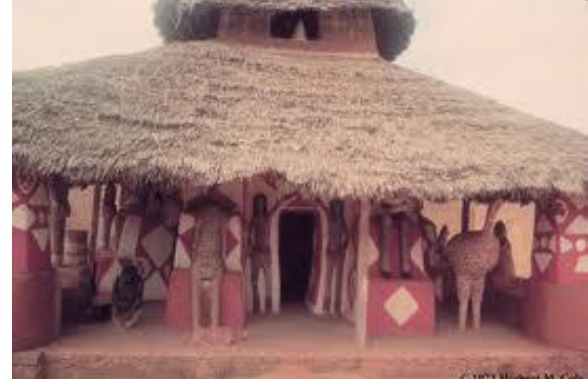
Figure 14 i. Mbari house.